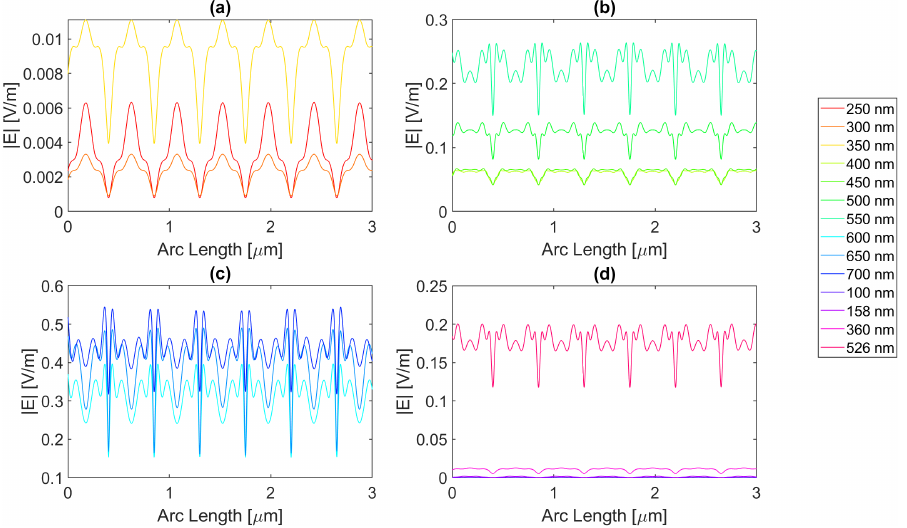
Figure 18. Electric field for the copper circular nanostructure with a 200 nm radius—Probe 1. Even though aluminium does show an improvement in the maximum electric field, being 4.49 × 10 − 1 V/m, the integral does not, as it falls just under the basic Si cell with a value of 1.20 × 10 − 6 , for a 600 nm wavelength. The results of the studied wavelengths can be found in Tables A4, A5, and A6 for probes 1, 2, and 3, respectively. For the range of wavelengths between 550 and 700 nm, the electric field intensity increases from probe 1 to probe 2, contrary to the field integral, which always decreases. At 700 nm, the intensity also increases for the third probe, while the integral decreases for all